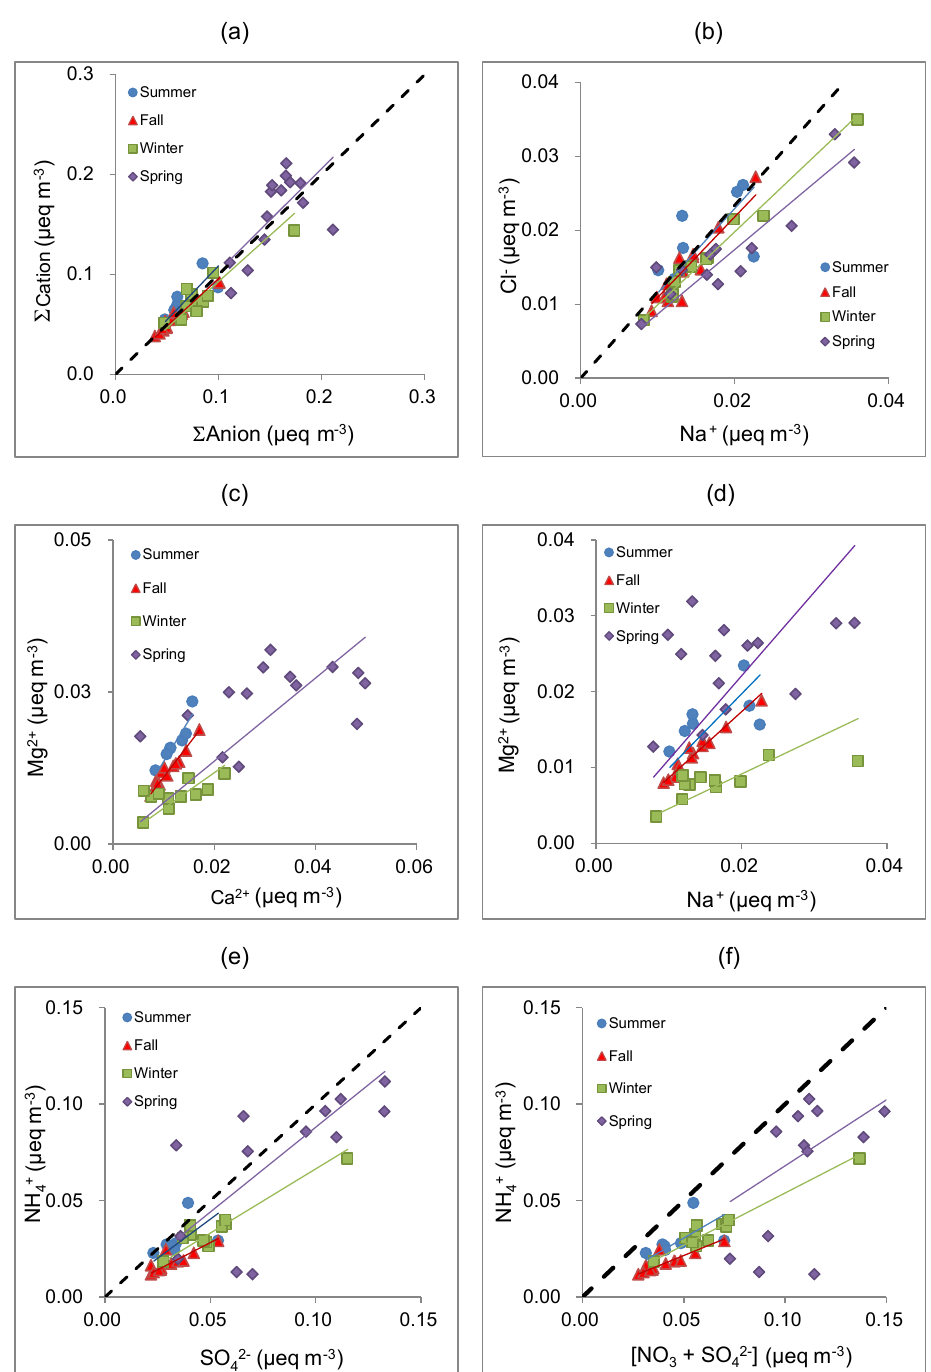
Figure 9. Scatter plot of (a) total anion and cation, (b) Na + and Cl − , (c) Mg 2 + and Na + , (d) Mg 2 + and Ca 2 + , (e) NH + + SO 2 − (f) NH + and NO − (unit in equivalent 4 3 4